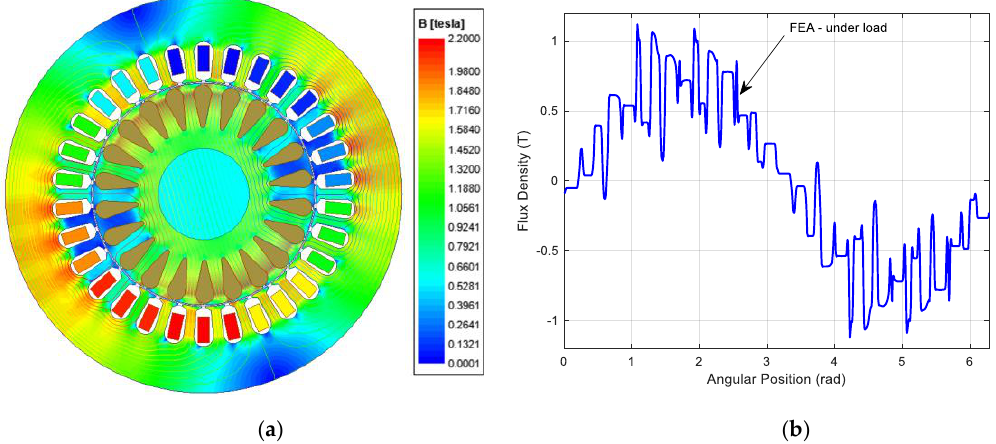
Figure 5. ( a ) Flux density distribution inside the machine under load, ( b ) air gap flux density.